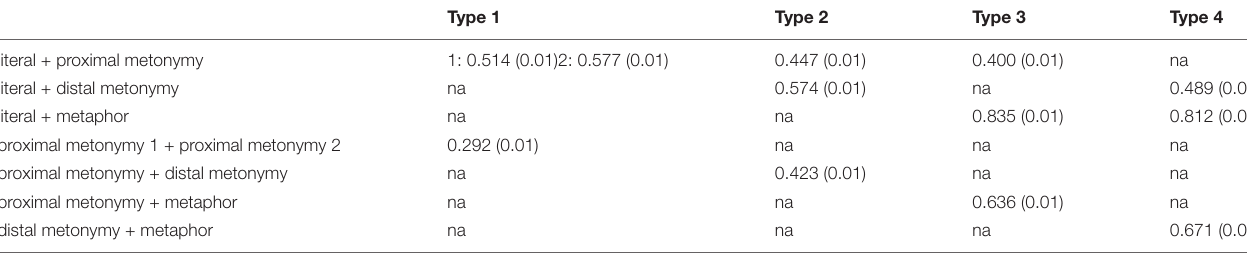
TABLE 4 | Adjusted Rand Index (with standard deviation) for each pairwise